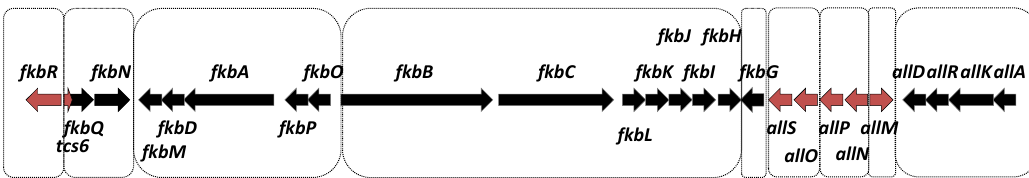
Figure 2. Tacrolimus biosynthesis cluster ( fkb ). Genes present in both the short and extended version of the fkb cluster are depicted in black. Genes present only in the extended version are depicted in red. These groups also correspond to their FkbN transcriptional dependence ( Black ) or independence ( Red ). The transcriptional units identified to date are indicated by